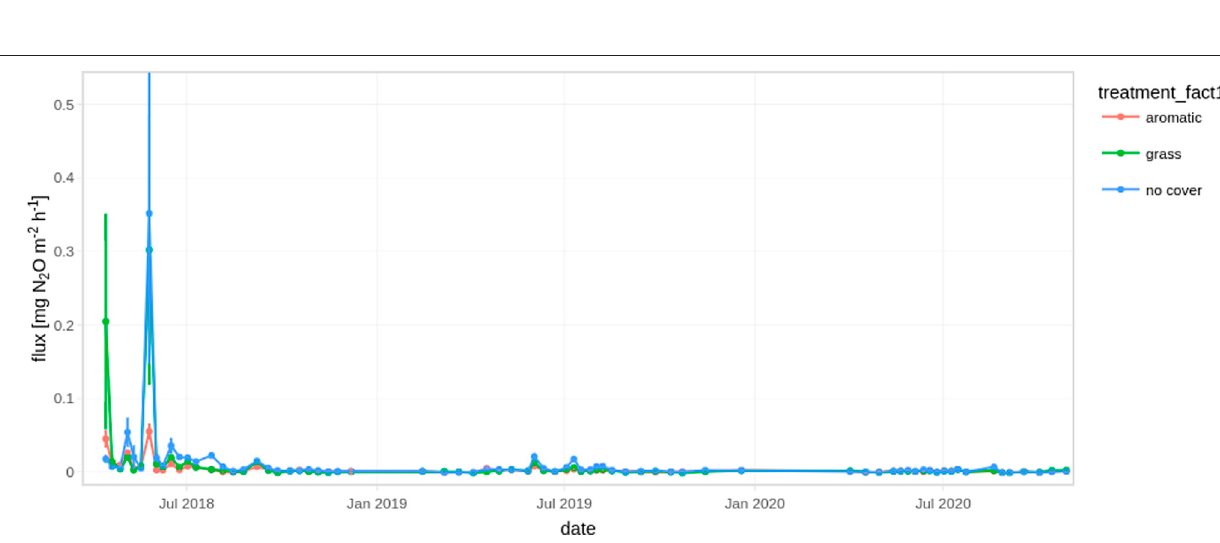
Frontiers in Environmental Science |